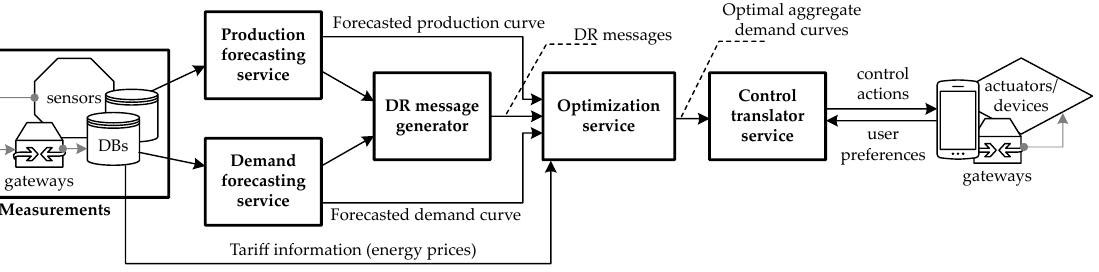
Figure 2. The RESPOND Artificial Intelligence (AI) system